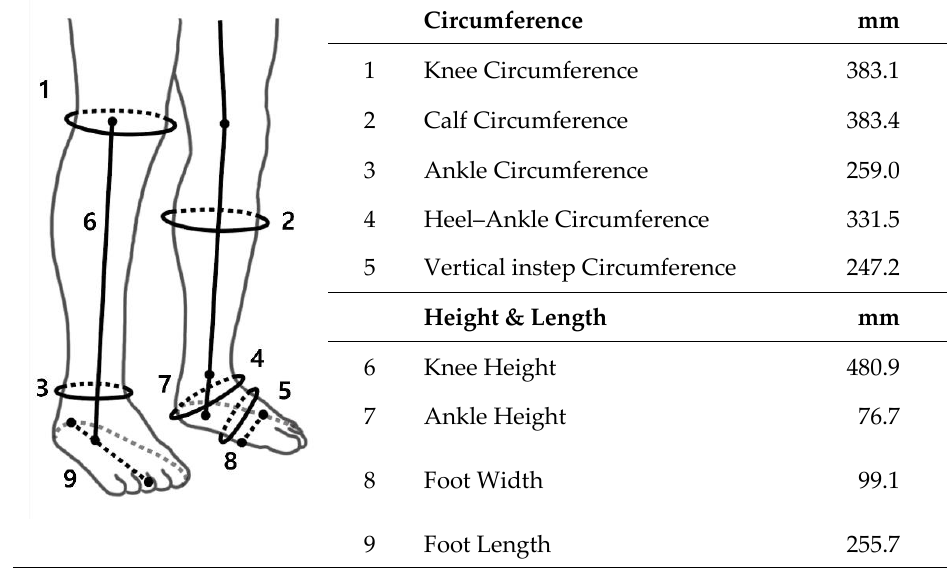
Figure 6. As kneE-XOcks is manufactured with a tight design that attaches to the body, it is necessary to use the precise actual size to maximize the wearability and auxiliary effects of kneE-XOcks. In order to reflect the body type of the main subjects in their 20 s and 30 s, the size of Korean adult males aged 20 to 39 years (measured by Size Korea) was referenced.